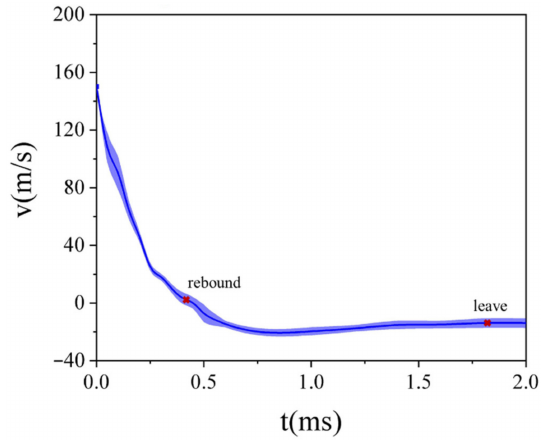
Figure 6. The velocity–time curve (with error band) of the projectile impacting the GFRP laminate at the velocity of 150 m/s.